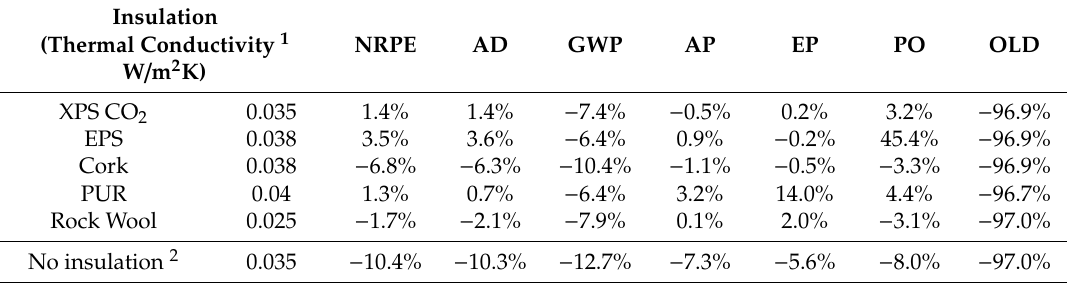
Table 6. Influence of alternative insulation materials on the life-cycle impacts of the house compared to the base case house (XPS